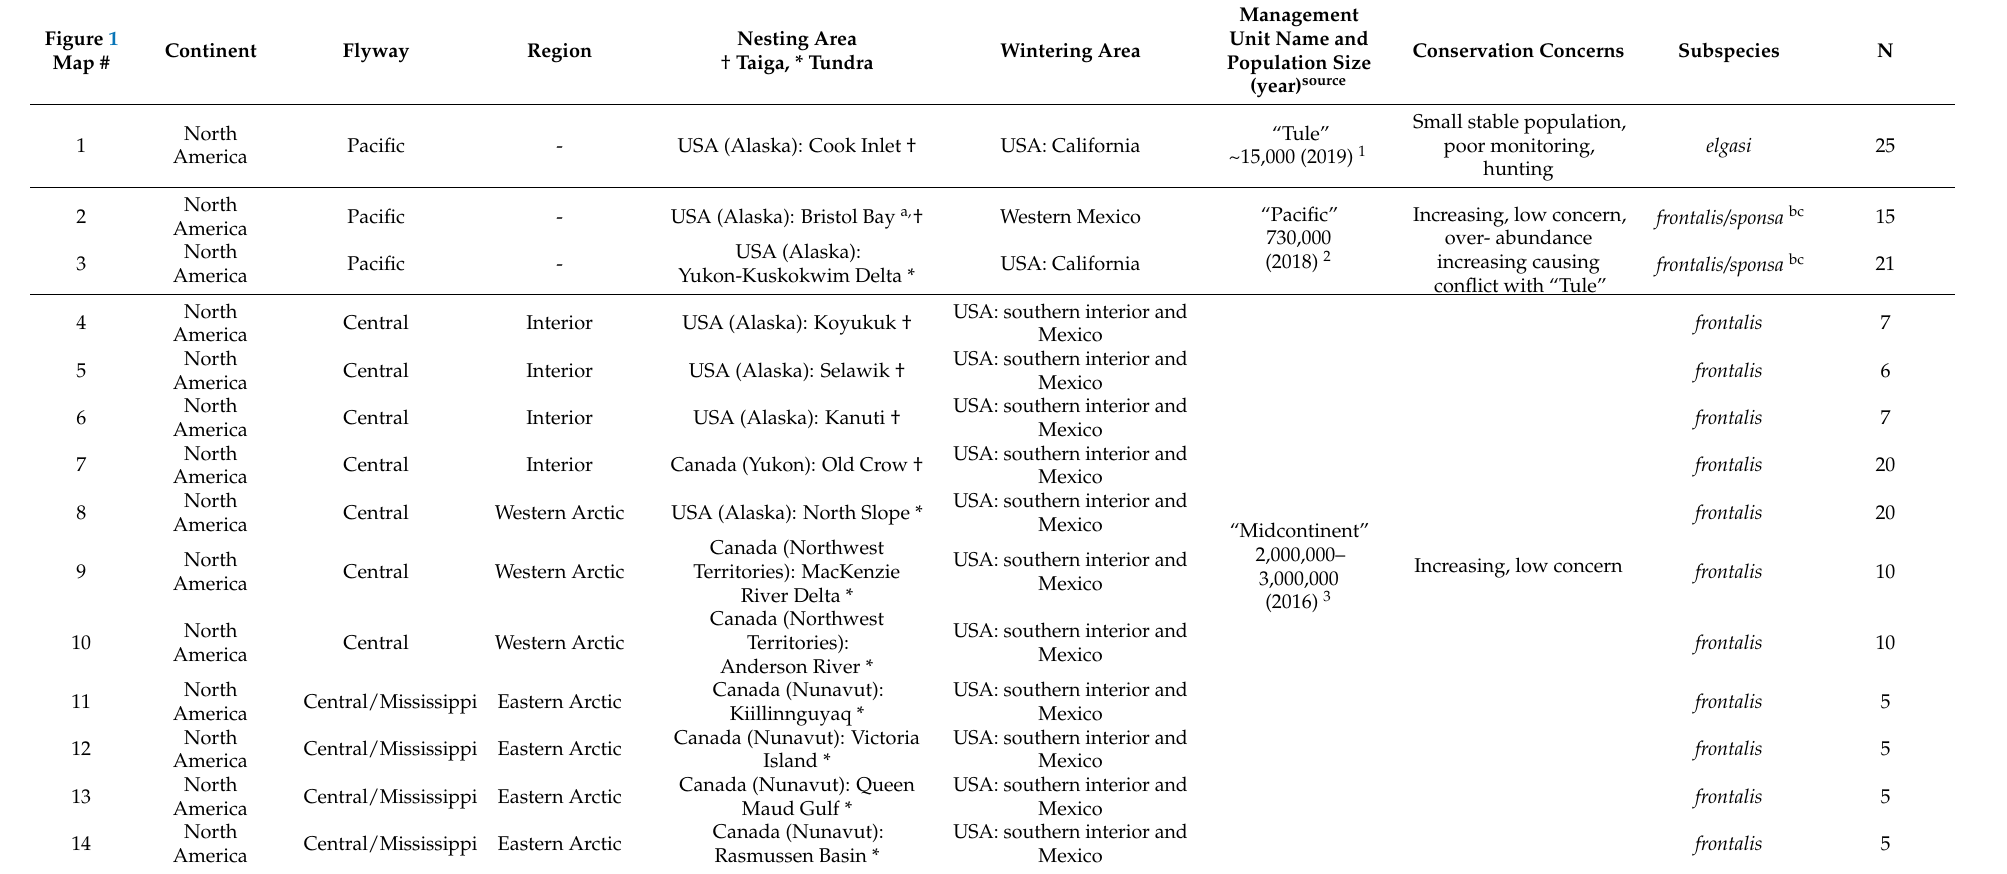
Table 1. General information on sampling areas and sample sizes (N) for the greater white-fronted geese included in this study including primary nesting (including habitat type: taiga † or tundra *) and wintering sites, management units and notes on conservation concerns. Numbers (#) in first column correspond to map locations in Figure